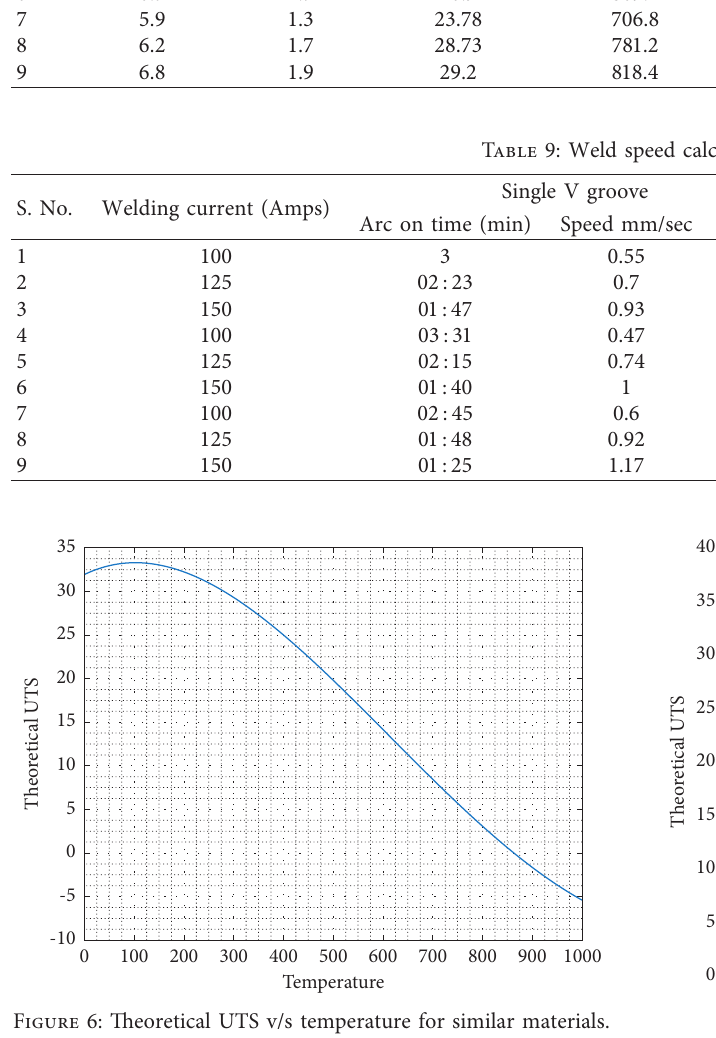
Figure 7: Theoretical UTS v/s temperature for dissimilar